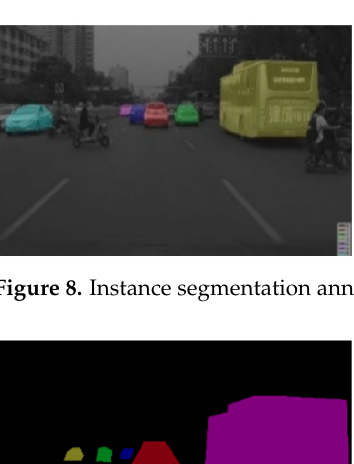
Figure 7. Polygon vehicle labeling.